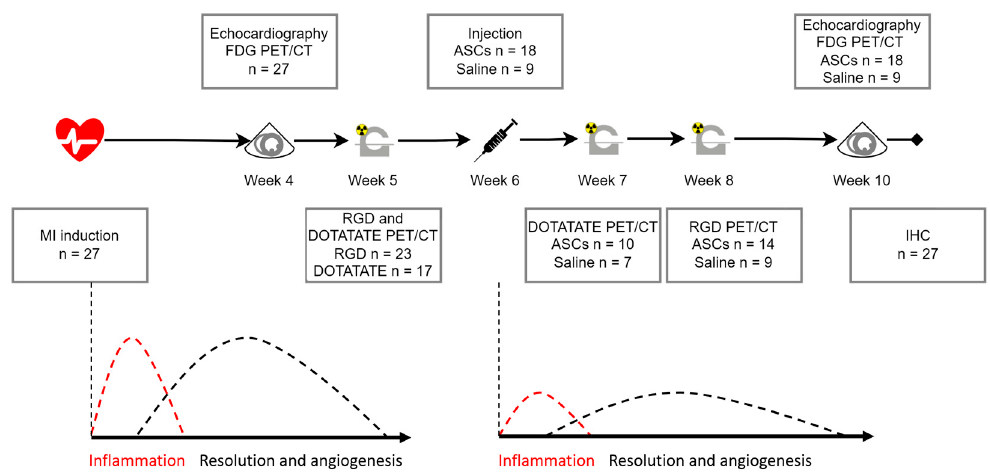
Figure 1. Study design with hypothesized cardiac wound healing phases. MI was induced at week 0, and the animals were allowed to recover for 4 weeks, to ensure the acute effect of the infarct was diminished. Echocardiography and 2-[ 18 F]FDG PET/CT for cardiac volumes and infarct area, respectively, were performed at week 4 for randomization. Pre-treatment PET/CT scans via [ 64 Cu]Cu-DOTATATE to detect baseline inflammation and [ 68 Ga]Ga-RGD to detect baseline angiogenesis was performed at week 5. In week 6, animals were treated with a trans-thoracic intra-myocardial injection of cryopreserved allogeneic rat ASCs or saline. The design was based on the hypothesis that treatment would initiate a new round of wound healing. Post-treatment scans with [ 64 Cu]Cu-DOTATATE were performed in week 6 (one week after treatment), while [ 68 Ga]Ga-RGD scans were performed in week 8 (two weeks after treatment). After follow-up echocardiography and 2-[ 18 F]FDG PET/CT in week 10 (four weeks after treatment), the rats were euthanized in week 11. MI: myocardial infarction; ASCs: Adipose tissue-derived stromal cells; PET/CT: positron emission tomography/computed tomography. The wound healing hypothesized time was based on Prahbu et al. as well as unpublished data.